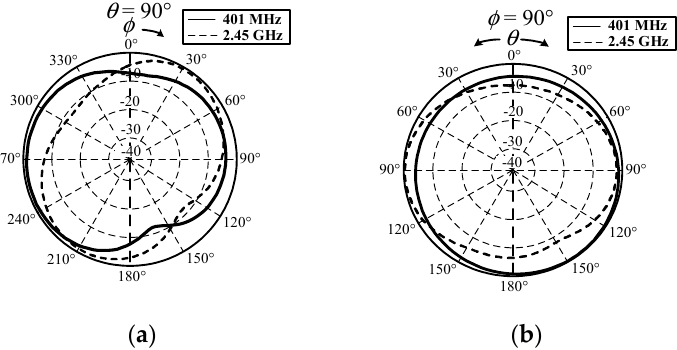
Figure 4. Simulated | S 11 | of MICS/ISM meander-line microstrip antenna encapsulated in a glass pod inside the muscular cubicle: ( a ) MICS and ( b ) ISM bands.